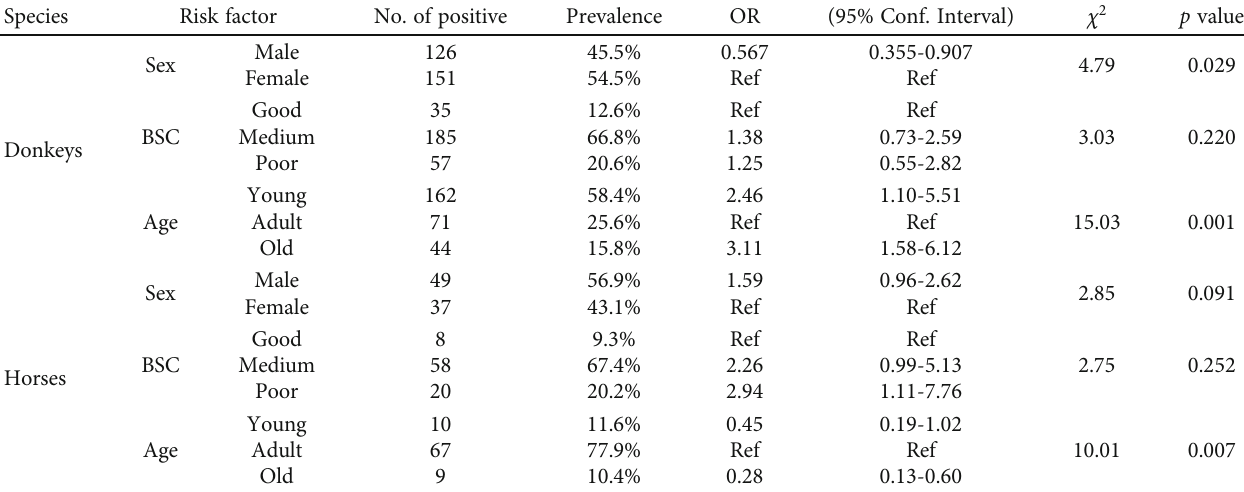
Table 2: Logistic regression analysis reporting odds ratio in donkeys and horses.